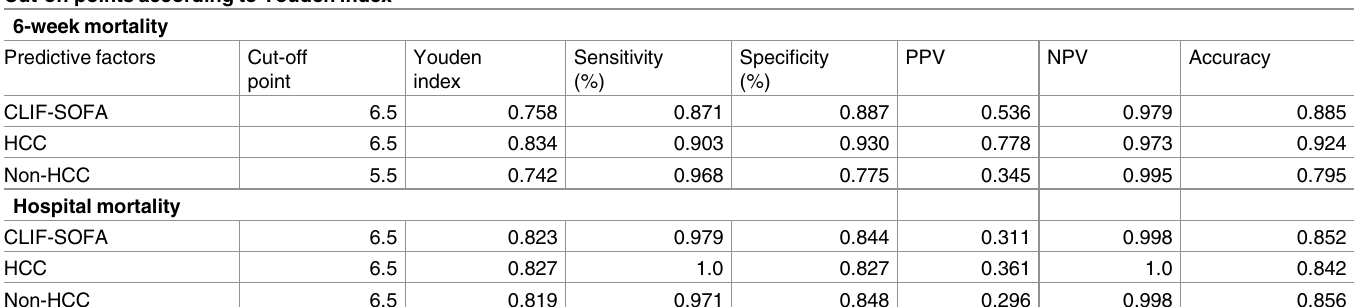
nonvariceal bleeding among full RS (0.57 vs. 0.80), pre-endoscopic RS (0.63 vs. 0.76), and GBS (0.63 vs. 0.66)[18]. Budimir et al. revealed AUROC for predicting variceal bleeding mortality among AIMS65, GBS and PRS were 0.74, 0.60, 0.67 respectively[19]. By contrast, Al-Freah et al. showed higher AUROC for predicting ICU hospital mortality variceal bleeding by CLIF- SOFA score (0.823), MELD score (0.839), and modified number of failed organs (0.843)[20]. In our cohort, CLIF-SOFA score predicted well for post EVL 6-week mortality as AUROC reached 0.943. According to the current literature, it seems that scoring systems consisting of liver function evaluation such as CLIF-SOFA and MELD scores predicted mortality more pre- cisely than RS and GBS, which were used widely for general upper gastrointestinal bleeding. Under pairwise comparison of area under the receiver operator characteristics, we indi- cated that the predicting power of CLIF-SOFA score was better than MELD score and CTP points for 6-week mortality of EVH post EVL in significant difference. The result could be explained by our multivariate hazard Cox analysis with parameters of scoring systems excluded. First, in addition to levels of serum bilirubin and creatinine, grade of hepatic encephalopathy, MAP, and respiration parameter SpO2/FiO2; these additional parameters were included in CLIF-SOFA score compared with MELD score. On the other hand, CLIF- SOFA score included five risk factors (grade of hepatic encephalopathy, SpO2/FiO2, MAP, serum bilirubin and creatinine) more than CTP points included two risk factors (serum albu- min and grade of hepatic encephalopathy). We also considered that EVH was an acute on chronic event. Thus, CLIF-SOFA score included not only relatively chronic parameters of the liver like MELD score and CTP points but also relative acute parameters such as SpO2/FiO2 and MAP.